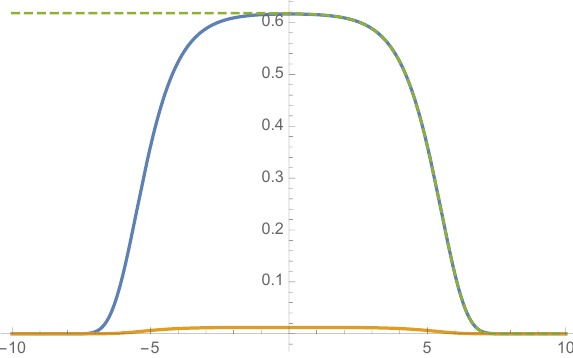
Figure 2 . Y − 1 ( θ ) as the function of θ for dimensionless volume r = 0 . 01 in blue. Dashed green shows the kink solutions. The difference between Y − 1 − Y − 1 visible. Thus for demonstration, we draw r − 12 5 δY − 1 with